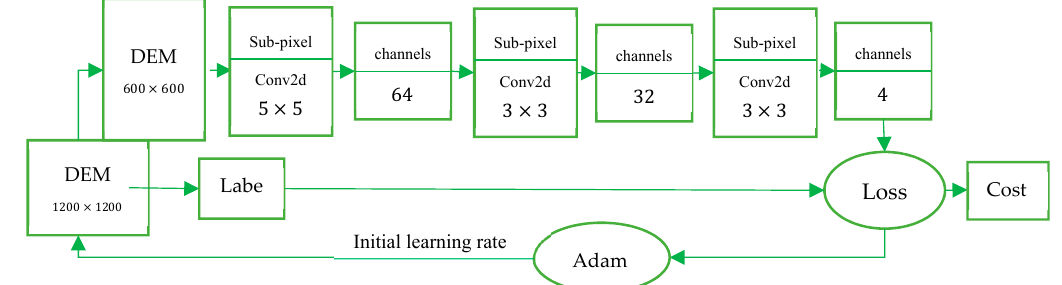
Figure 7. The network’s structure, containing three convolutional layers, and finally outputting 4-channel datasets.